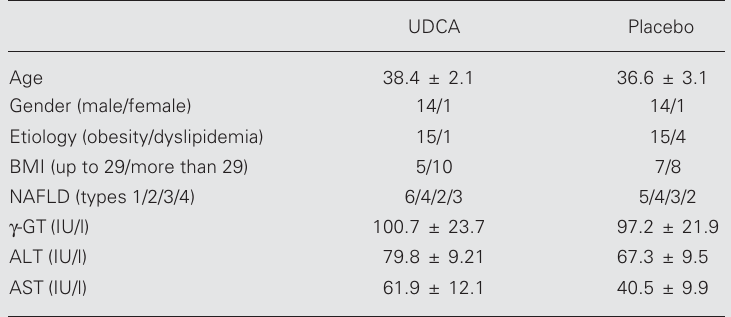
Table 1. Clinical and histological data for UDCA-treated and placebo groups of obese patients with nonalcoholic fatty liver disease. UDCA Placebo